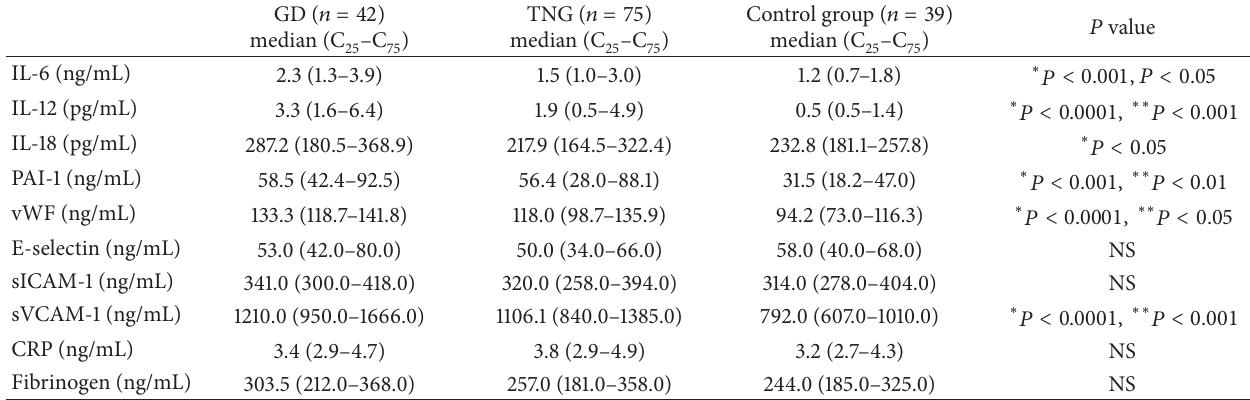
Table 3: Selected markers of inflammation and endothelial dysfunction in the patients with Graves disease (GD), toxic nodular goitre (TNG), and in the control